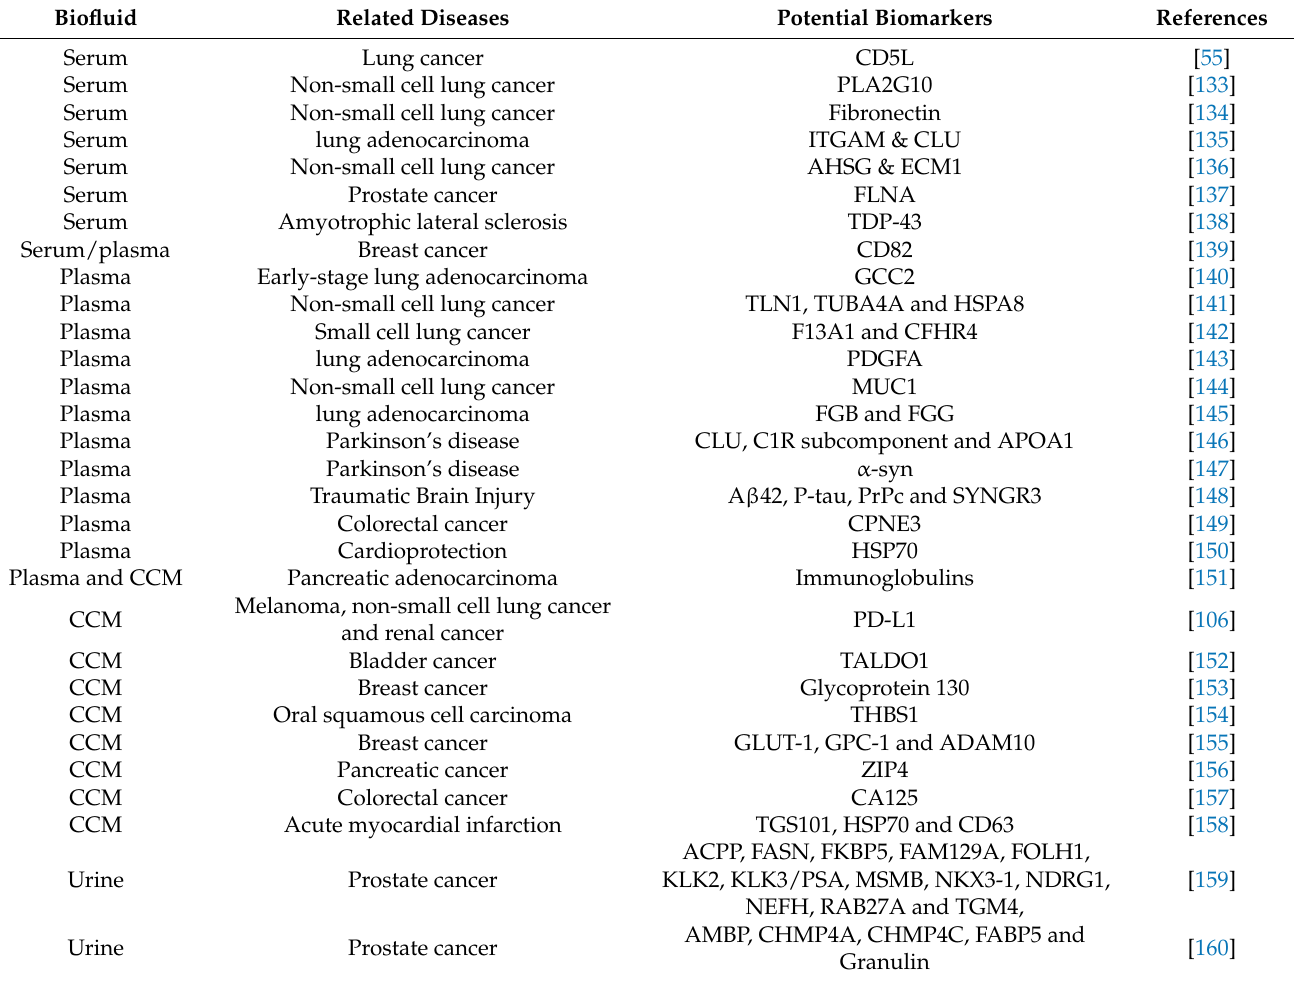
Table 1. Summary of exosomal proteins as potential biomarkers for